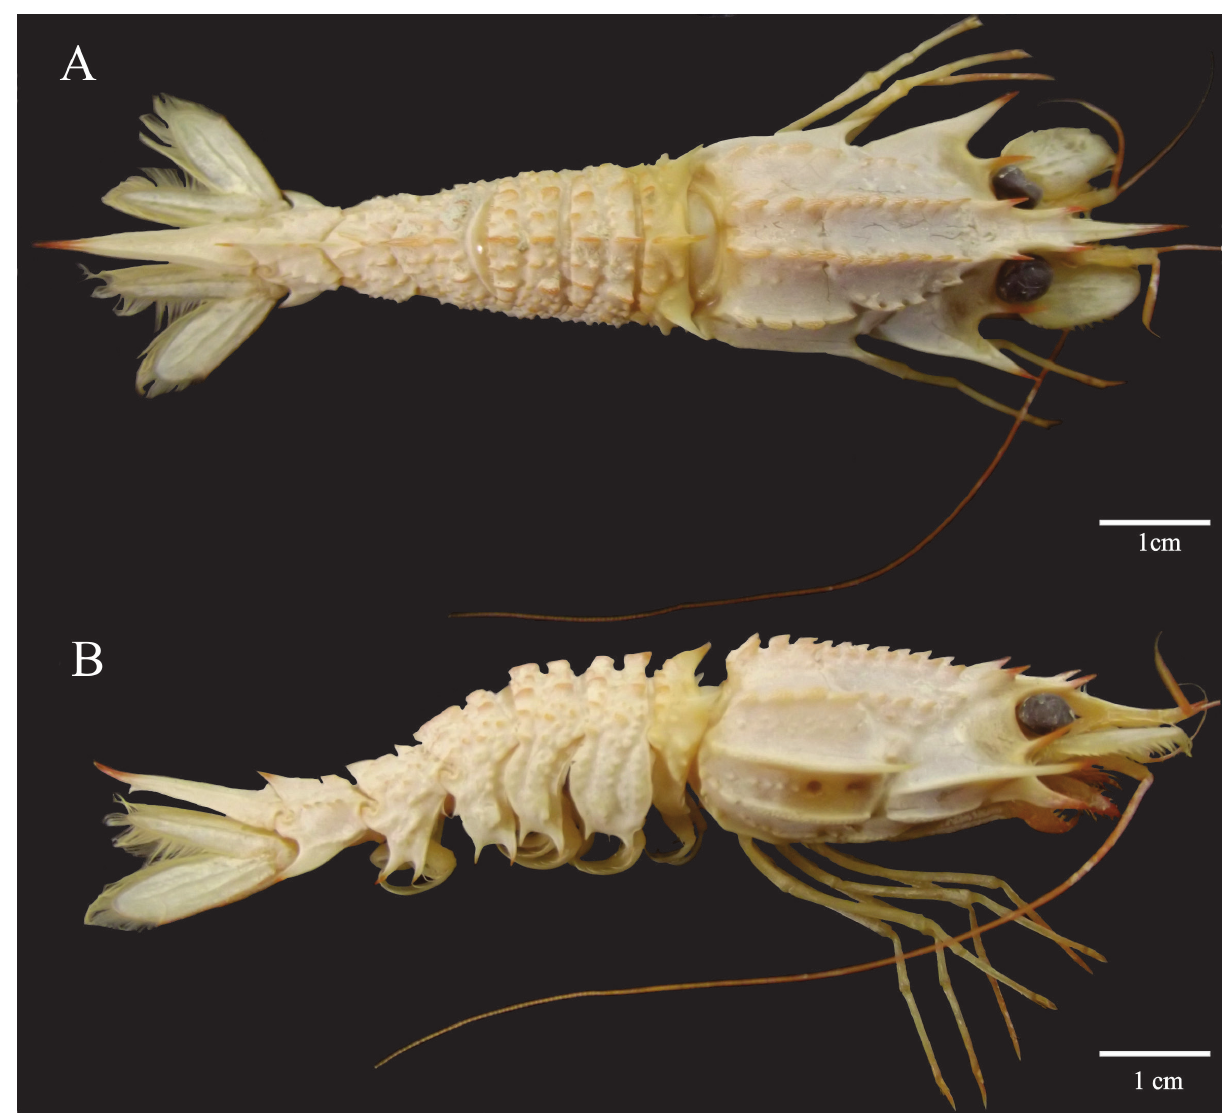
Figure 2. Glyphocrangon aculeata A. Milne-Edwards, 1881, dorsal (A) and lateral (B) views, male (TL-75.5 mm; Bpot-Talude MT# 72-2; MOUFPE 15.162), northeastern